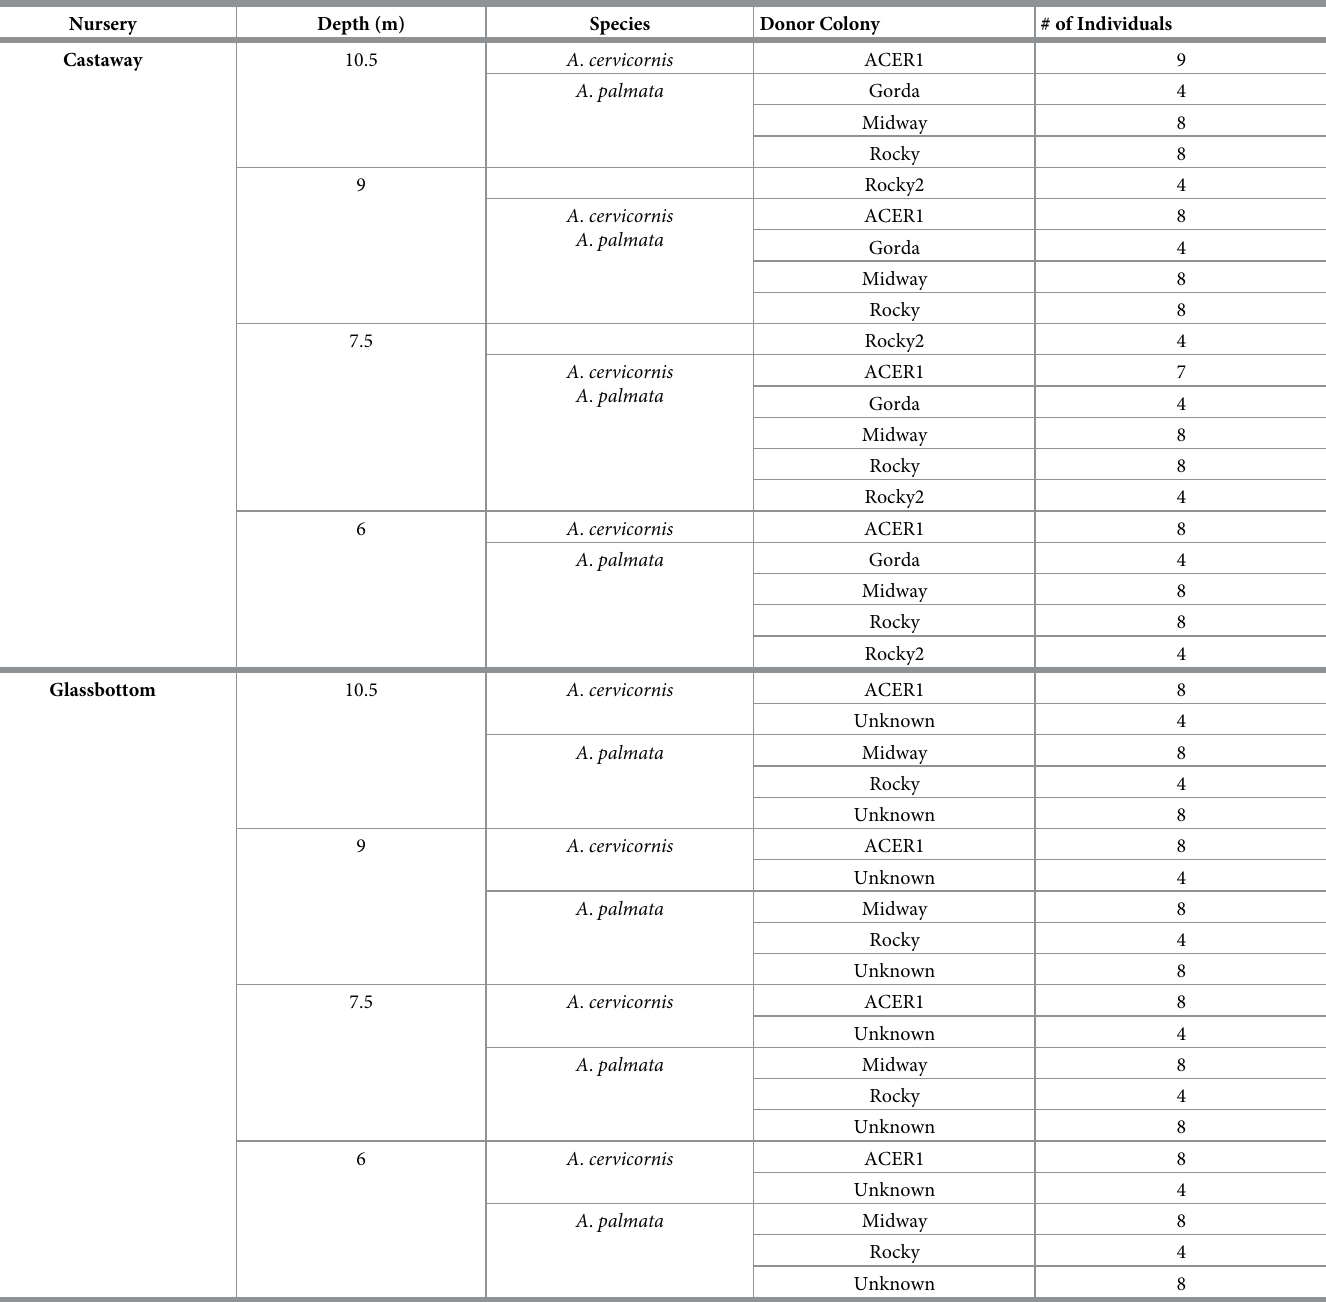
Table 1. Number of corals from different colonies for two coral lines nurseries at varying depths in The Bahamas. Nursery Depth (m) Species Donor Colony # of Individuals Castaway